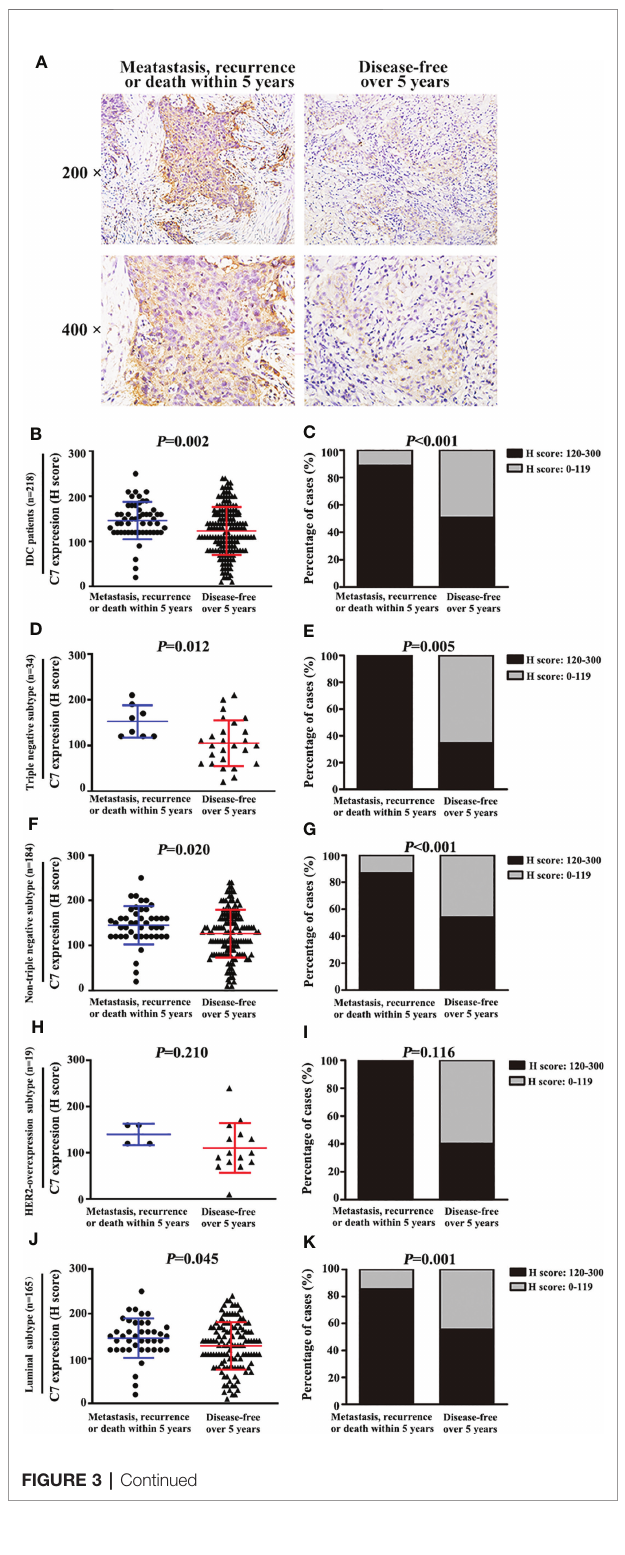
( P = 0.003, Figure 5A ) and PFS ( P < 0.001, Figure 5B ) in patients treated with TE-based chemotherapy. However, no correlations